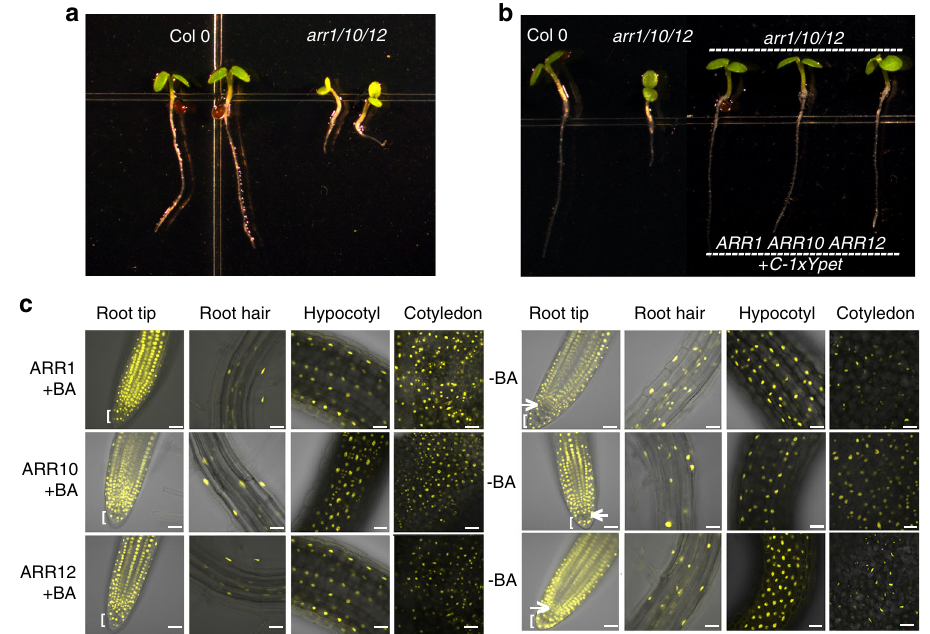
Fig. 1 B-ARRs protein localization upon cytokinin treatment. a The phenotype of 3-days-old arr1/10/12 triple mutants grown under long day (16-h light/8-h dark) conditions on MS. b Recombineering B-ARRs with Ypet at C-termini ( + C-1xYpet) can rescue arr1/10/12 triple mutant phenotypes. c The protein localization of B-ARRs in plants after 4-h treatments of 10 µ M 6-BA ( + BA) and DMSO ( − BA). Three individual plants for each factor were imaged and representative images were presented ( n = 3). Images of root tip regions (Root tip), root hair regions (Root hair), hypocotyls (Hypocotyl), and the adaxial side of cotyledons (Cotyledon) are shown. Arrows indicate the quiescent center. Square brackets indicate the columella cells. Scale bar = 40 µ